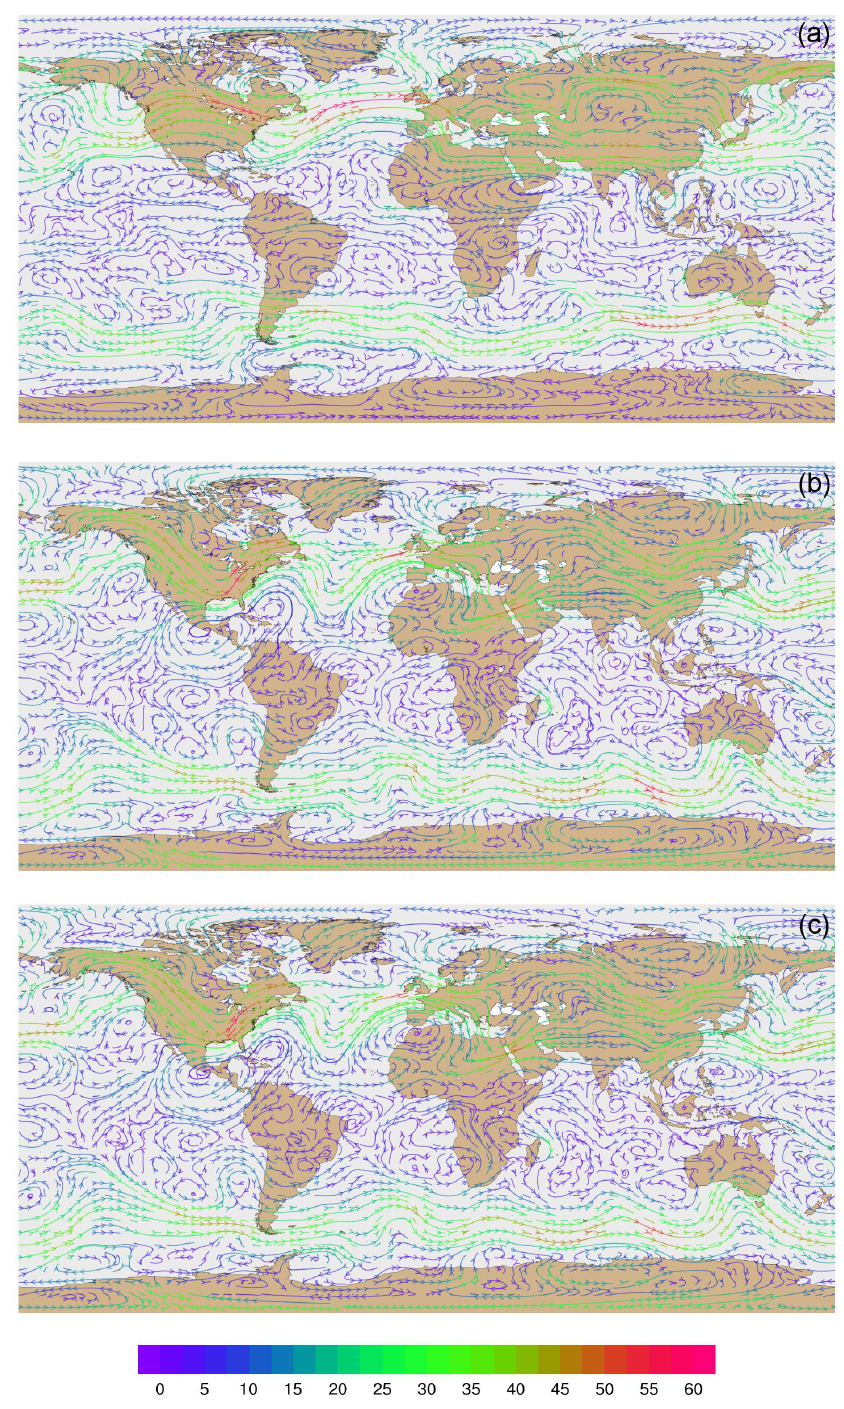
Figure 9. Global streamline analyses for layer 28 ( ∼ 500–300hPa) at 00:00UTC on 31 January 2013 (a) from MPAS-A without FDDA, (b) FDDA target field, and (c) MPAS-A using FDDA. Streamline color indicates wind speed (ms − 1 ) .